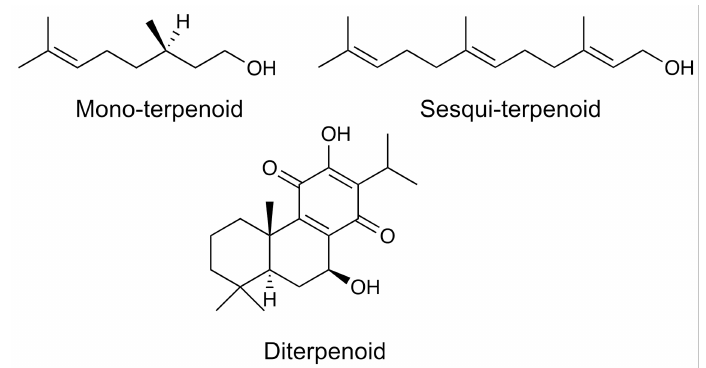
Figure 5. Examples of some terpenes and